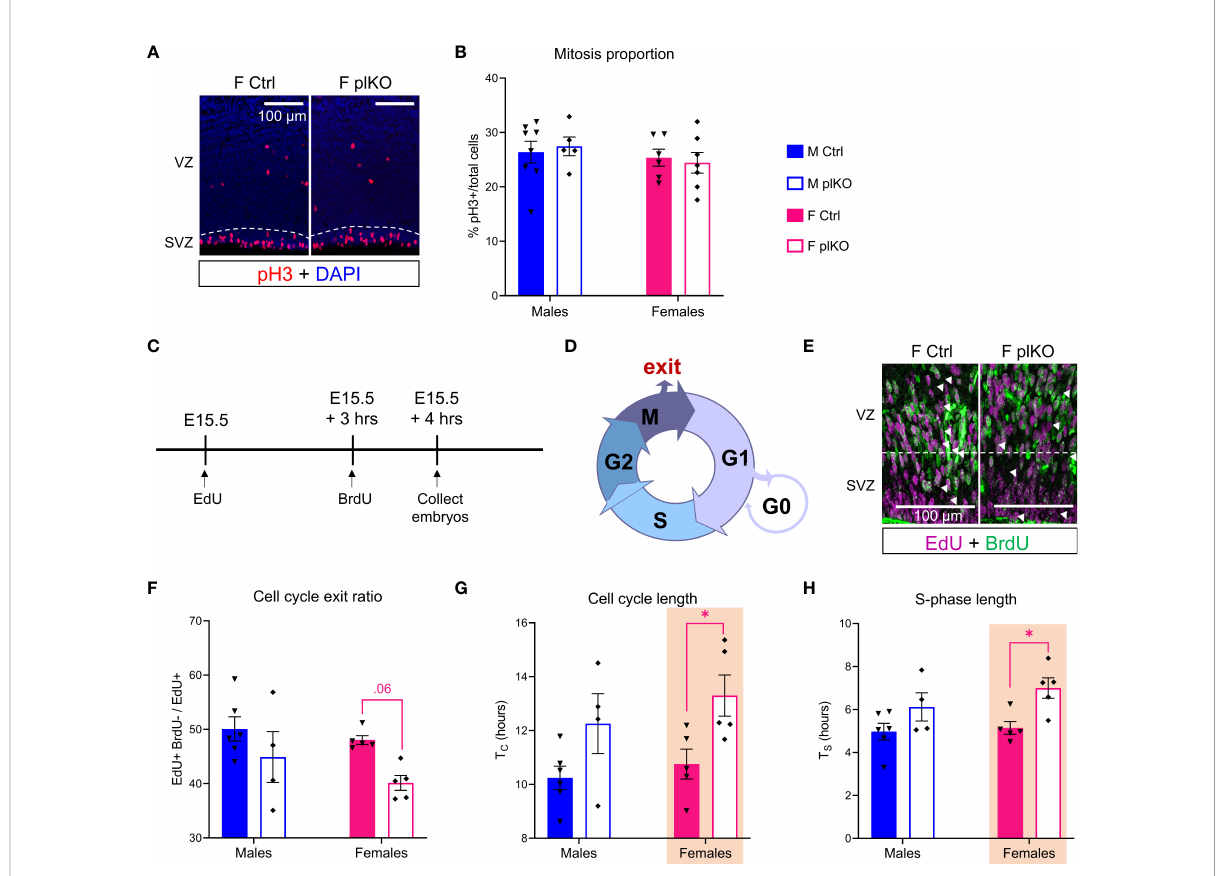
FIGURE 5 In fl uence of placental ALLO insuf fi ciency on mitosis and cell cycle kinetics in the cerebral cortex during mid-to-late gestation. (A) Immuno fl uorescent staining of pH3, a mitotic marker, in the cerebral cortex at E15.5. (B) Quanti fi cation of (A) reveals no change in the proportion of SVZ cells undergoing active mitosis in the plKO cerebral cortex at E.15.5. n = 8 M Ctrl, 6 F Ctrl, 5 M plKO, 7 F plKO. (C) Overview of experiments to determine cell cycle exit and kinetics at E15.5. (D) The different phases of cell cycle. (E) Immuno fl uorescent staining of EdU (magenta), marking proliferating cells at E15.5, dual pulsed with BrdU (green), injected 3 hours later, to identify cells in cycle and cells that had exited. (F) Quanti fi cation of the cell cycle exit ratio in the SVZ shows a signi fi cant loss in cell cycle exit in plKO mice at E15.5. (G) Signi fi cant increase in the SVZ cell cycle length (Tc) in plKO females associated with an (H) elongated S-phase (T S ). n = 6 M Ctrl, 5 F Ctrl, 4 M plKO, 5 F plKO. Data presented as mean ± SEM. Two-way sex by genotype ANOVA with Sidak ’ s post-hoc comparison test: *p < 0.05 identi fi ed in magenta for females. F, female; M, male; pH3, phospho-Histone 3; SVZ, subventricular